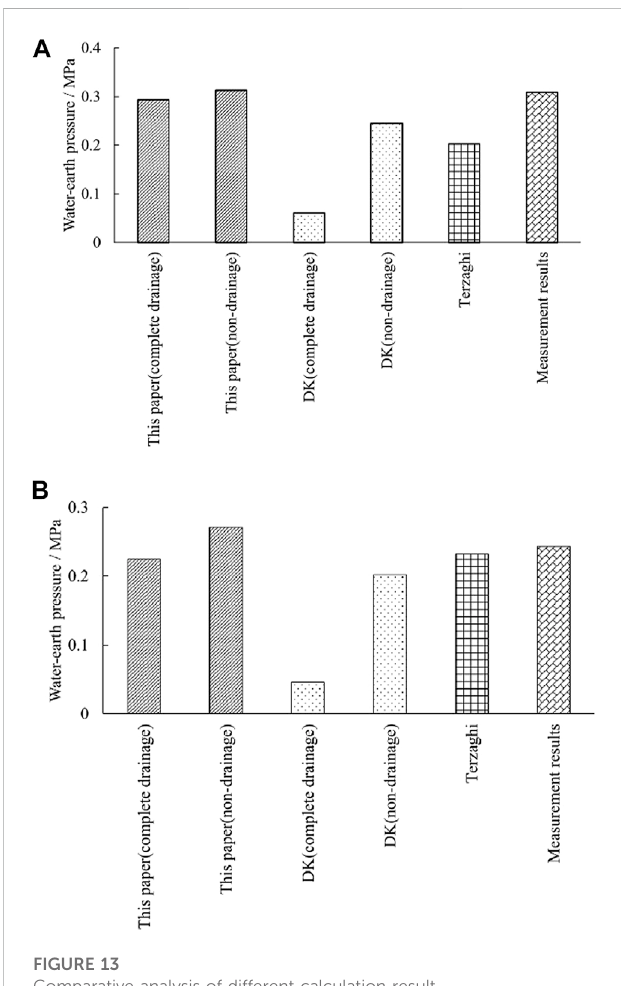
FIGURE 13 Comparative analysis of different calculation